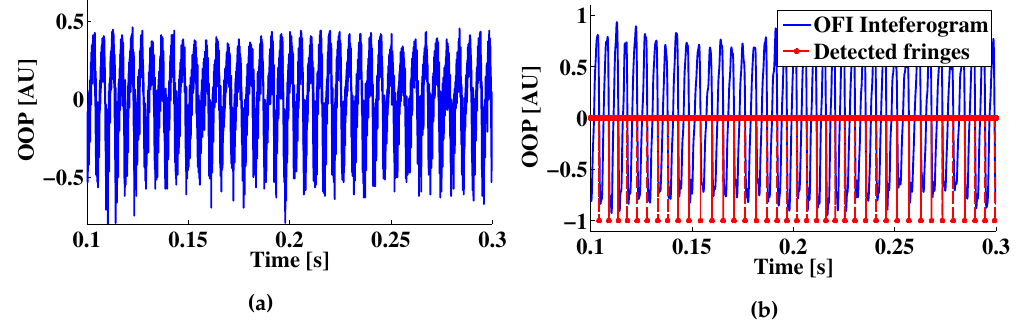
Figure 6. OFI signal fringe detection. ( a ) An example of an experimentally-acquired OFI signal of a ramp-like motion with v r = 76 µ m/s; ( b ) The OFI signal shown in ( a ) after filtering and fringe